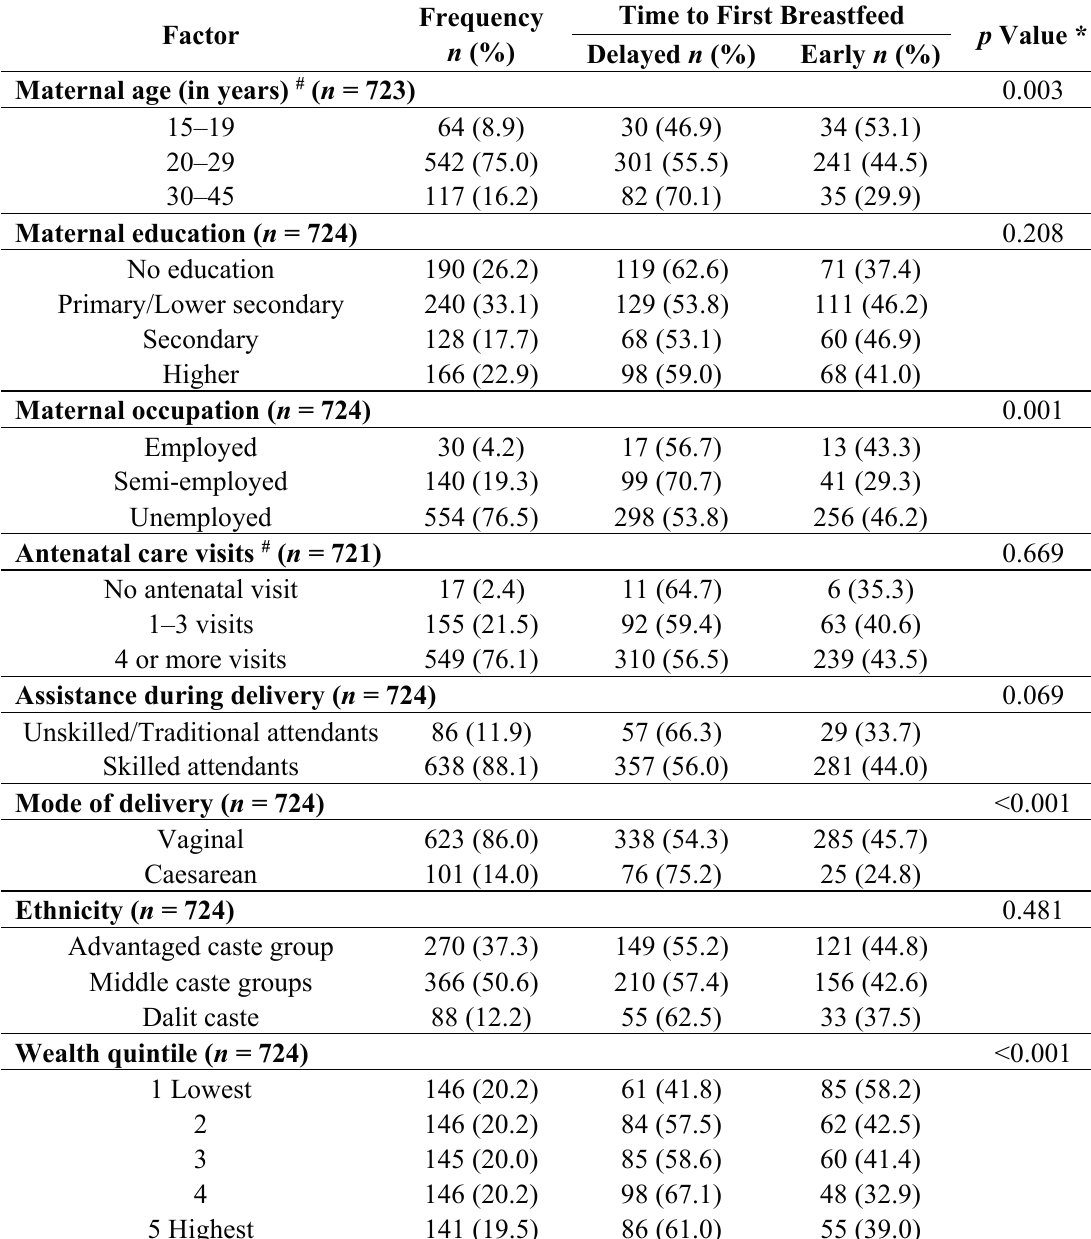
Table 1. Characteristics of participants according to time to first breastfeed in western